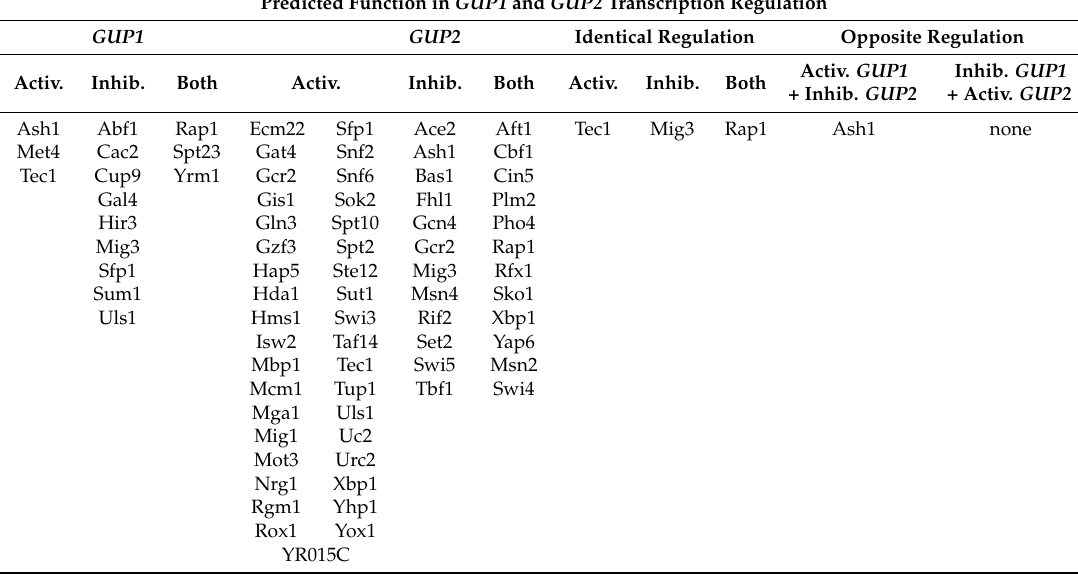
Table 2. Documented transcription factors that function as regulators of Gup1 and Gup2 [46]. Activ.: activator; Inhib.: